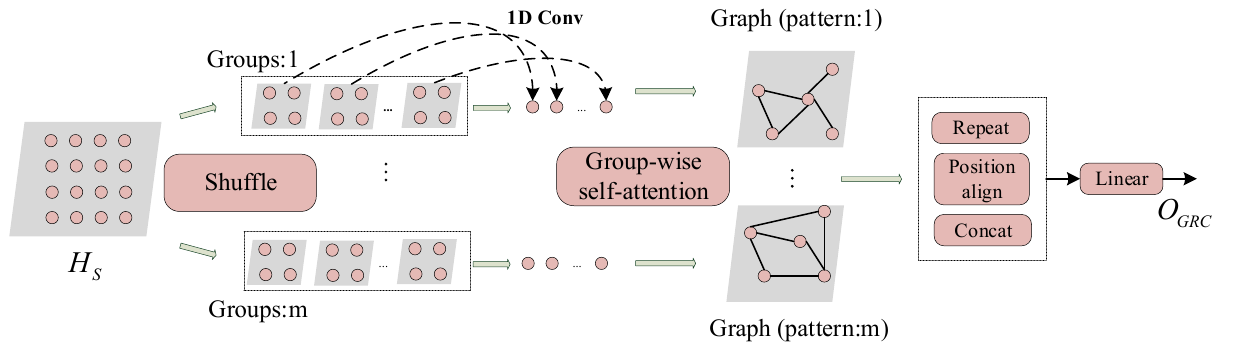
Figure 3. The Group-Range Convolutional Attention.